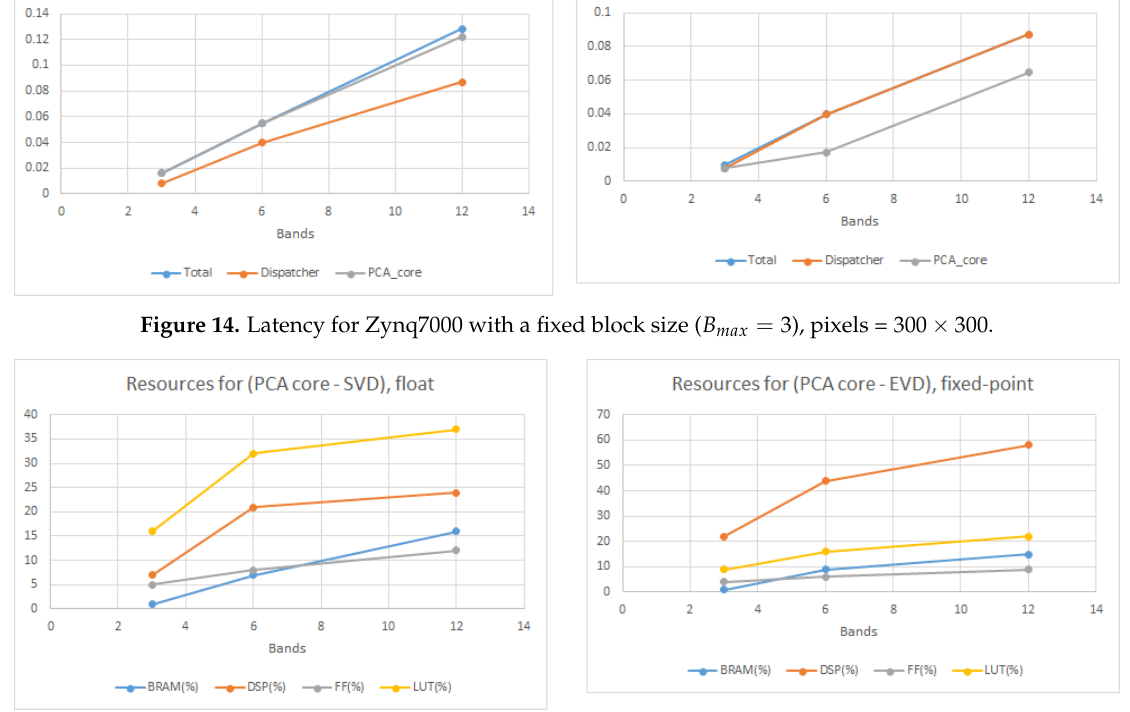
Figure 15. Resource usage for Zynq7000 with a fixed block size ( B max = 3), pixels = 300 × 300.